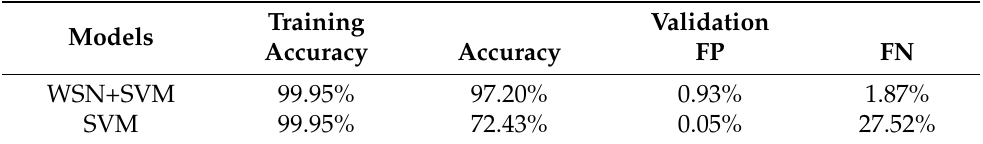
Table 1. Accuracy and false rates of classifying vertical traces with or without the WSN (Type-I dataset).